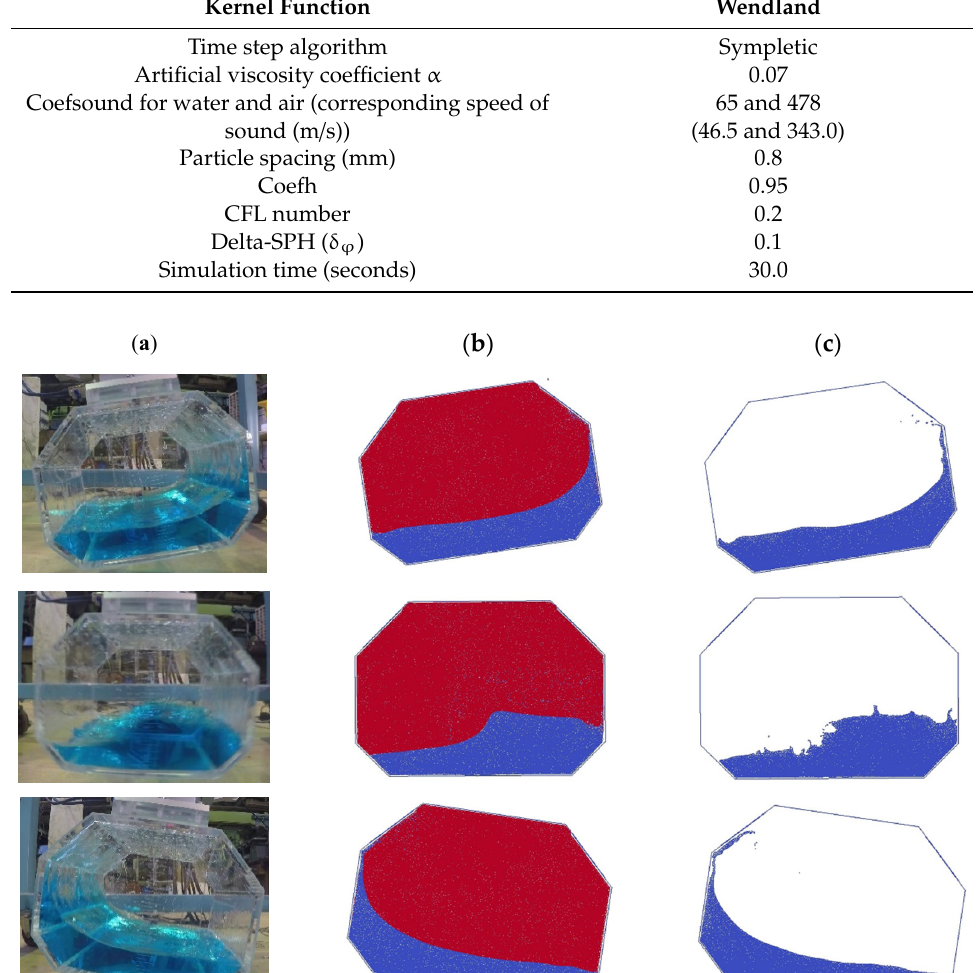
Table 6. Computational settings in DualSPHysics.